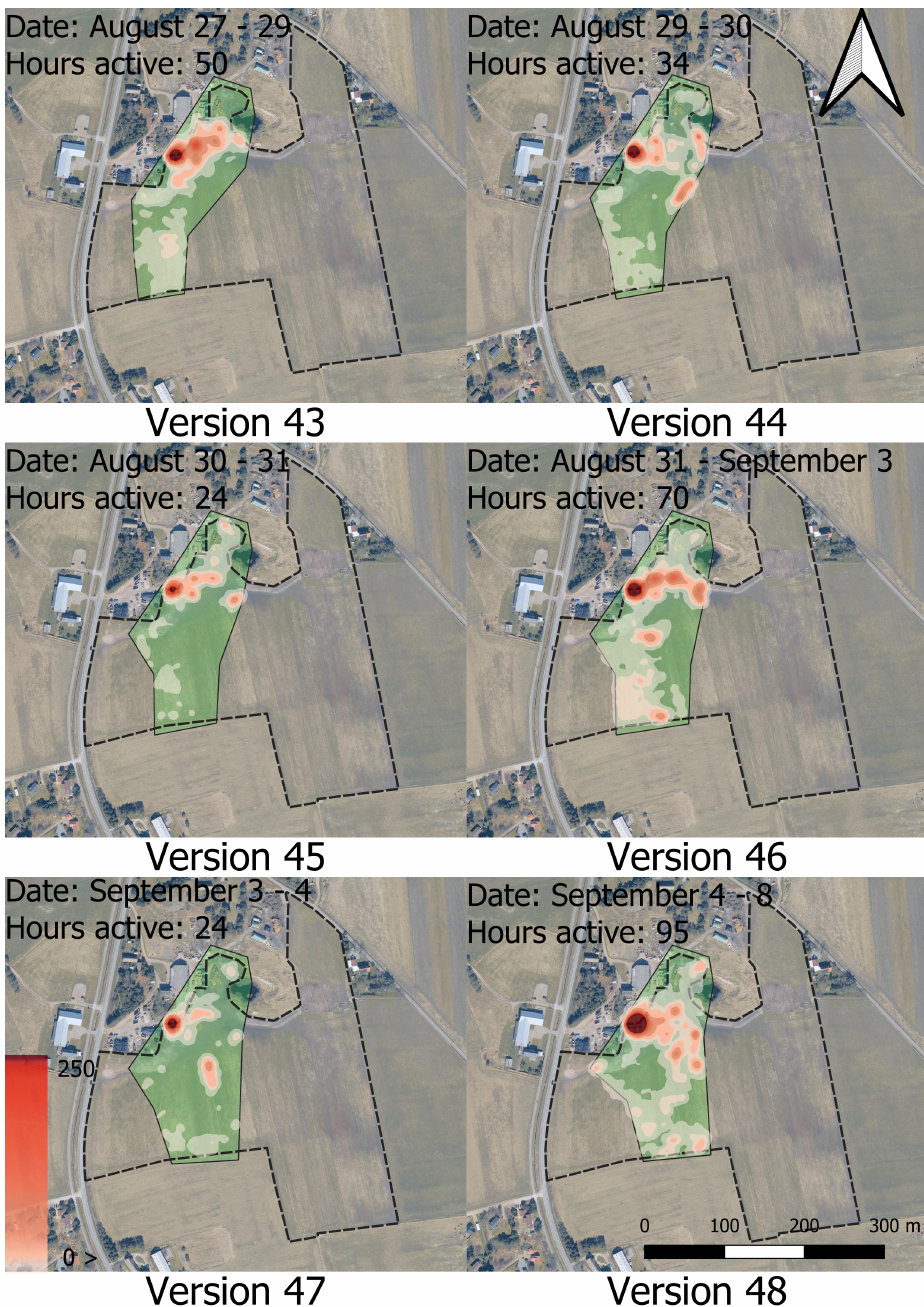
Figure A17. Heatmap series 8 visualising all Poll messages sent during the period from 27 August to 8 September. The green area shows the virtual enclosure area to which the bull calves were limited. The white to red colour indicates the number of Poll messages within a 10 m radius. The brightest colour represents the areas with the lowest density of Poll messages, while the darkest colour represents the areas with 250 or more Poll messages within the radius. The coordinates of the upper left corner of the map frame are 55°25 (cid:48) 23.131 (cid:48)(cid:48) E 8°23 (cid:48) 53.531 (cid:48)(cid:48) N. Contains data from the Agency for Data Supply and Infrastructure, Forårsbilleder Ortofoto-GeoDanmark, December